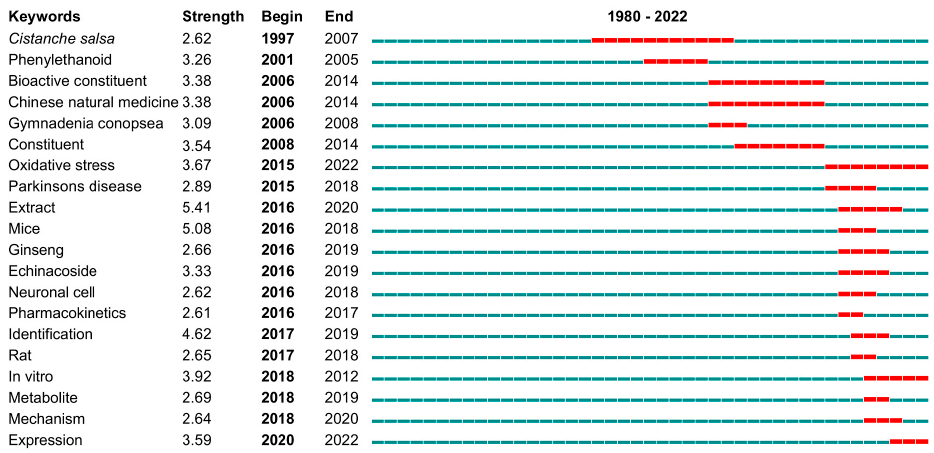
Figure 7. Top 20 keywords with the strongest citation bursts in Cistanche -related study (1980–2022). The time period of the citation burst is indicated by the red